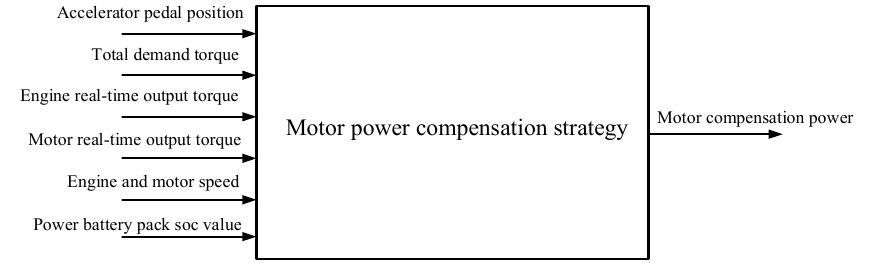
Figure 16. Basic principle of motor power compensation strategy.